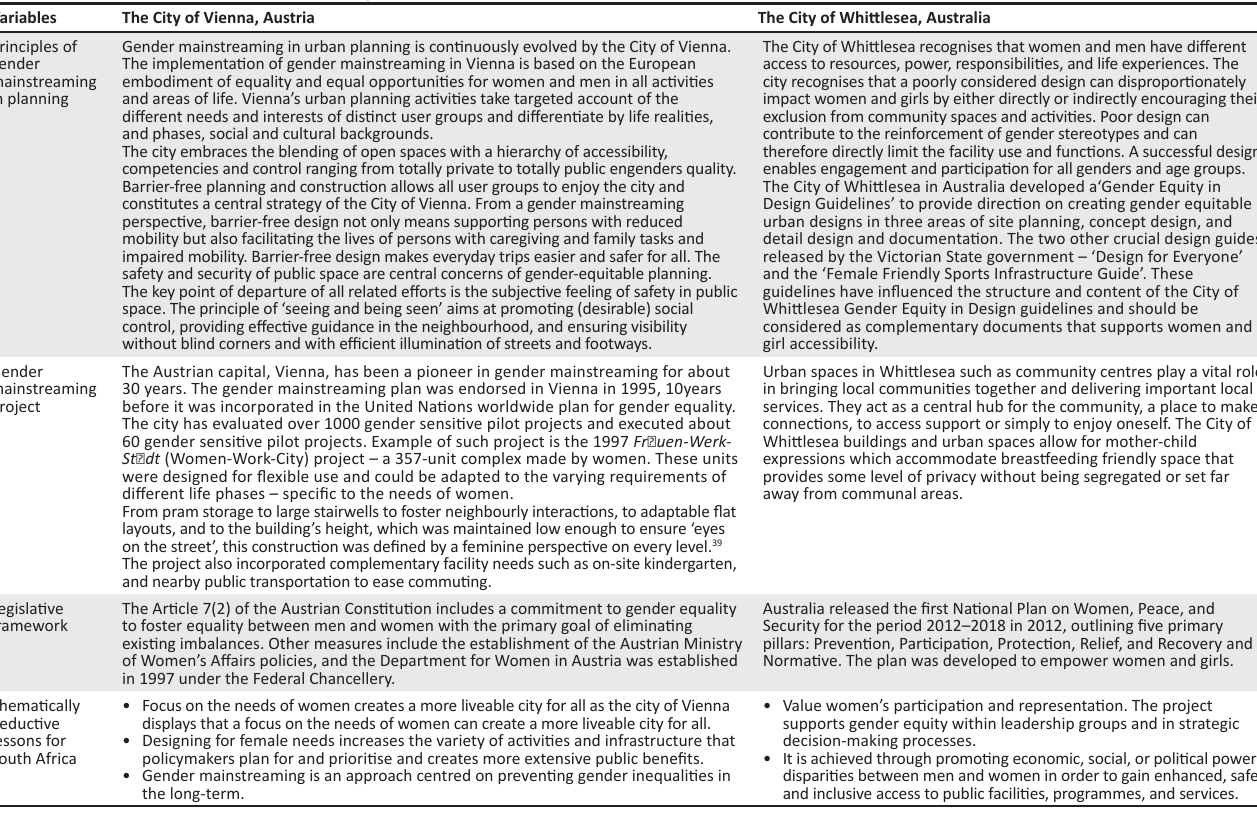
TABLE 1: Global case studies of women in urban